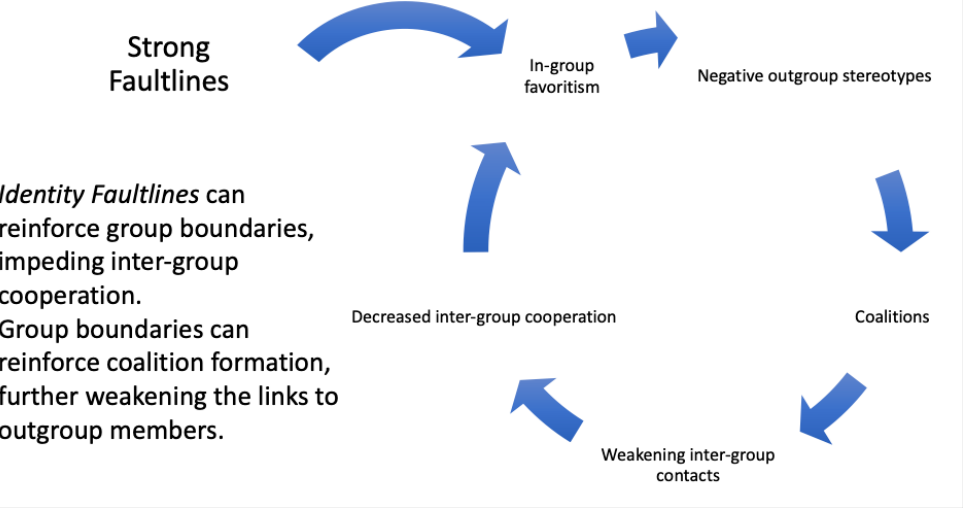
Figure 4: Example for an Identity